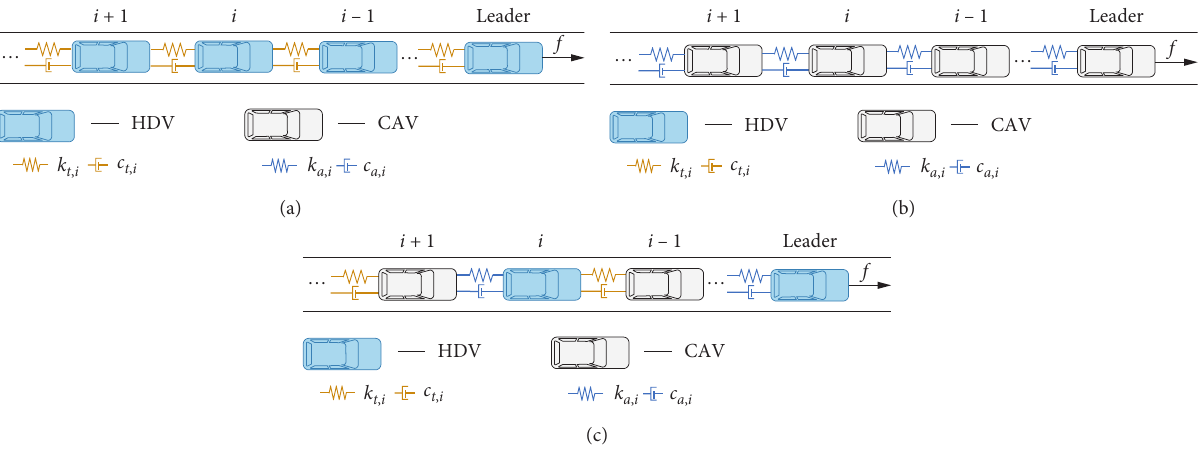
Figure 2: MSD car-following models. (a) MSD model for HDVs. (b) MSD model for CAVs. (c) Mixed MSD